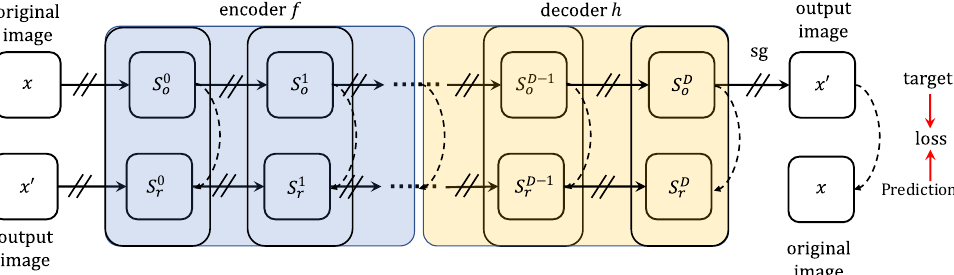
Figure 1. The local activity contrast (LAC) algorithm trains an autoencoder by reducing the local activity contrast of individual neurons in two forward passes of the original and reconstructed images. Specifically, in the first forward pass with the original image input, we record the activation value of each layer as the “target”, and we use the activation value of each layer in the second forward pass with the reconstructed image input (coming from the first forward pass) as the “prediction”. Each layer has its own independently defined LAC losses with which the gradients are calculated. Note that the gradient does not flow across layers (stop gradient: